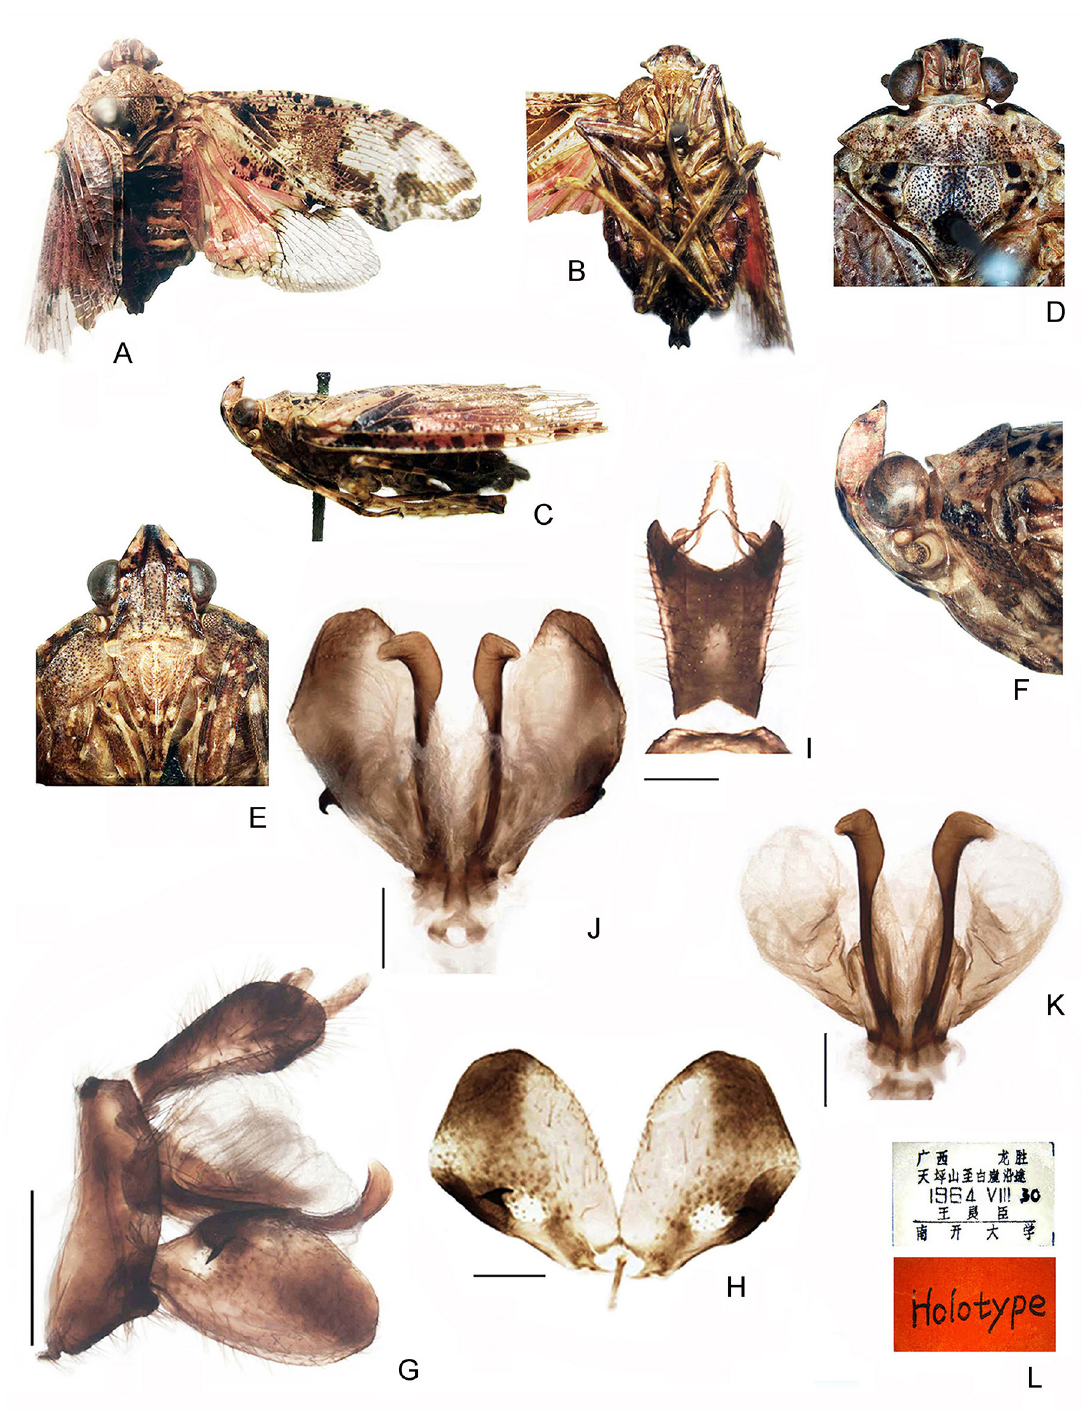
Fig. 2. Limois guangxiensis Chou & Wang, 1985. A – F . Holotype, female. A . Adult, dorsal view. B . Adult, ventral view. C . Adult, left lateral view. D . Head and thorax, dorsal view. E . Face. F . Head and thorax, left lateral view (showing reflexed protuberance of the vertex). G – K . NWAFU HO088509, male genitalia. G . Left lateral view. H . Gonostylus, ventral view. I . Anal tube, dorsal view. J . Aedeagus and gonostylus, dorsal view. K . Aedeagus, ventral view. L . Labels of the holotype. Scale bars: G = 1.0 mm; H–K =0.5